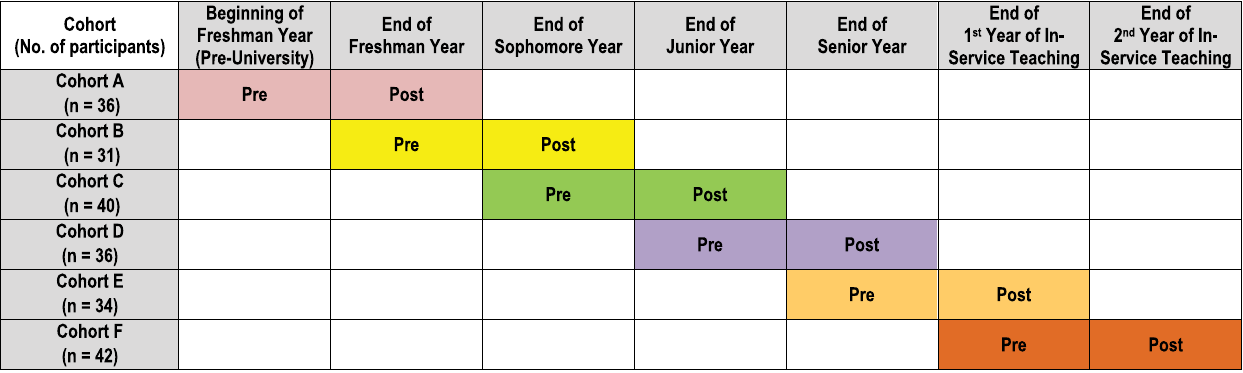
FIG. 1. A Cross-sequential study of six cohorts of participants, each underwent a full academic year of undergraduate studies or in- service teaching. For example, cohort A took the pretest prior to the freshman year (pre-university) and took the post-test at the end of the freshman year. Cohort B, for another example, took the pretest at the end of their freshman year and took the post-test at the end of sophomore year. Cohort F, for yet another example, took the pretest at the end of the 1st year of teaching and took the post-test at the end of the 2nd year of